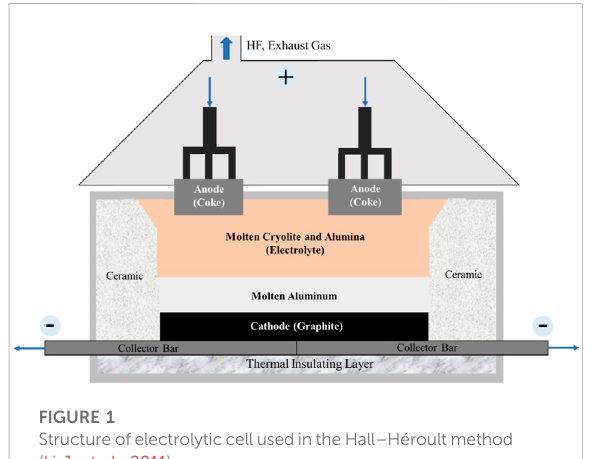
FIGURE 1 StructureofelectrolyticcellusedintheHall – Héroultmethod (Li J. et al., 2011).